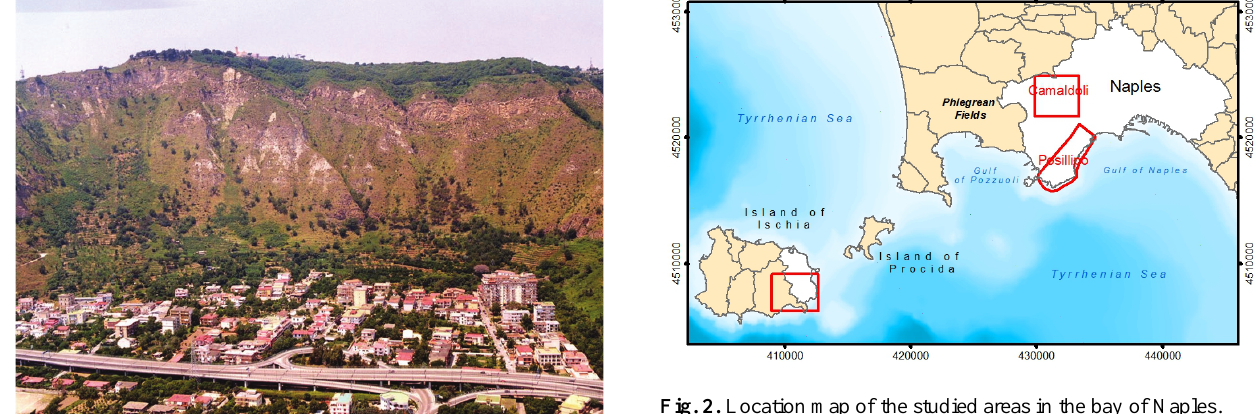
Fig. 2. Location map of the studied areas in the bay of